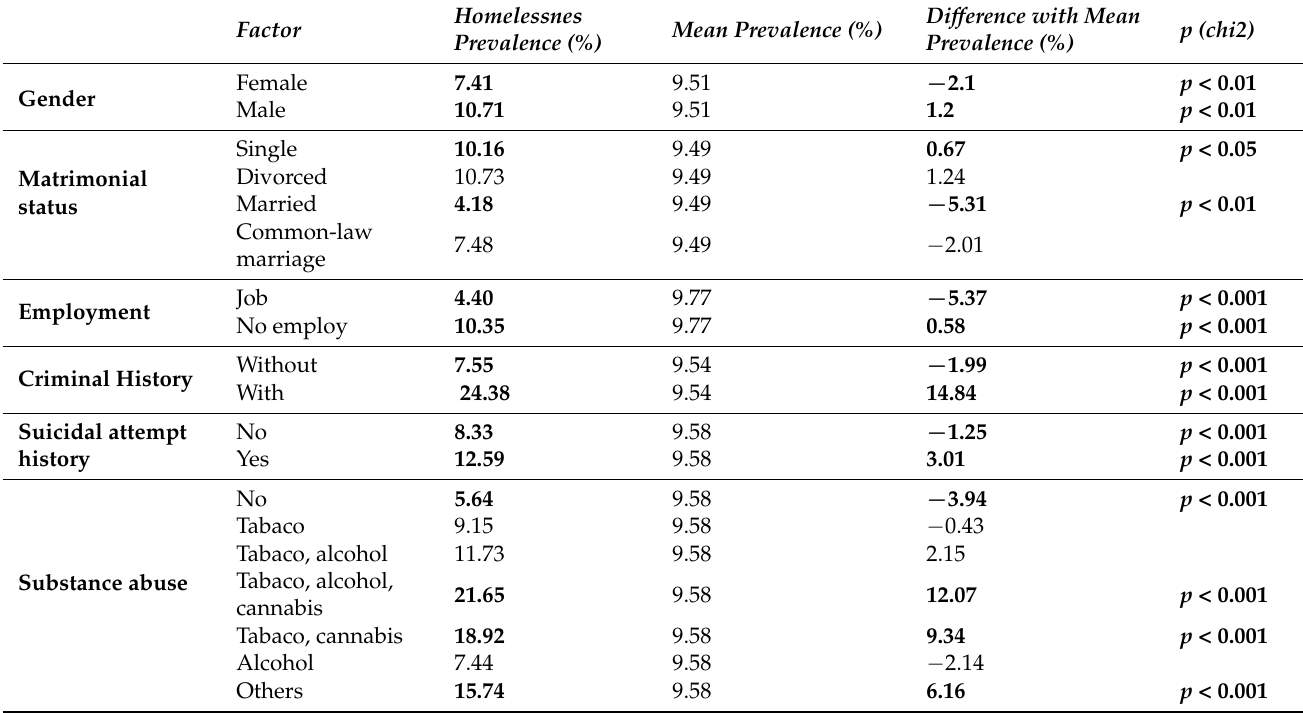
Table 2. Analysis of usual risk factors of homelessness in REHABase